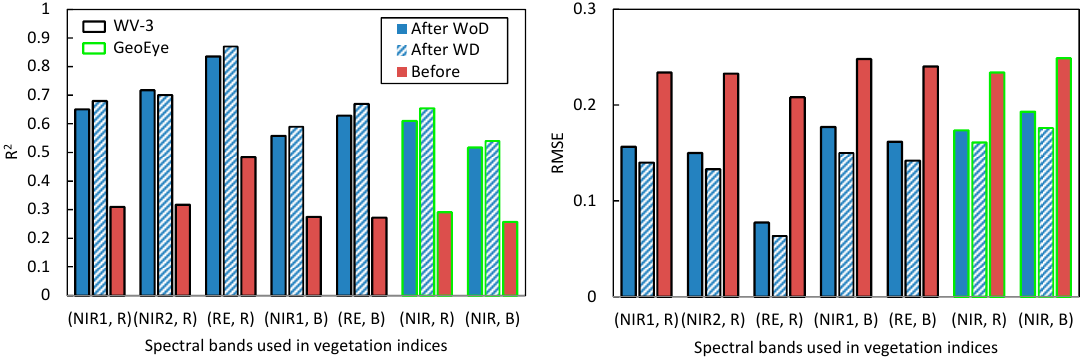
Figure 12. R 2 and RMSE of regressions between VIs and SAV fractions before and after water-column correction with (WD) and without (WoD) accounting for deep-water reflectance R ∞ rs .